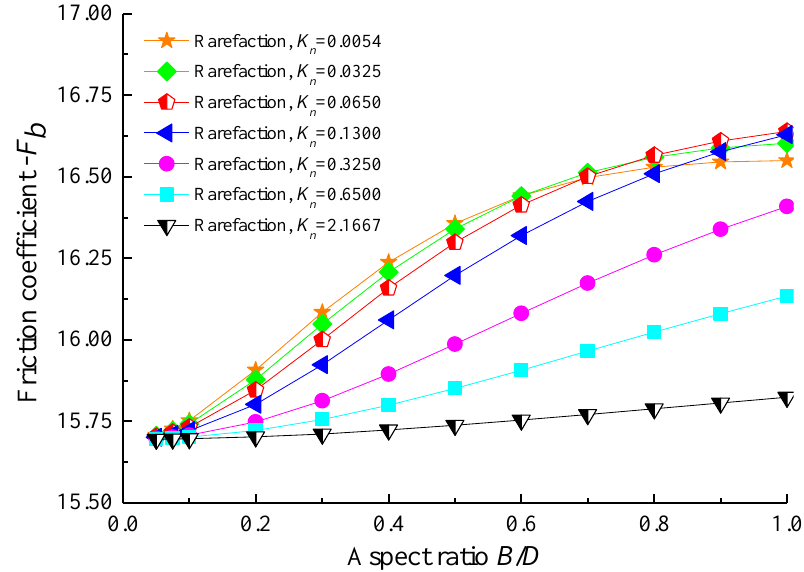
Figure 8. Friction coefficient of Boltzmann model vs. aspect ratio for different Knudsen numbers ( Λ = 5, ε = 0.6).